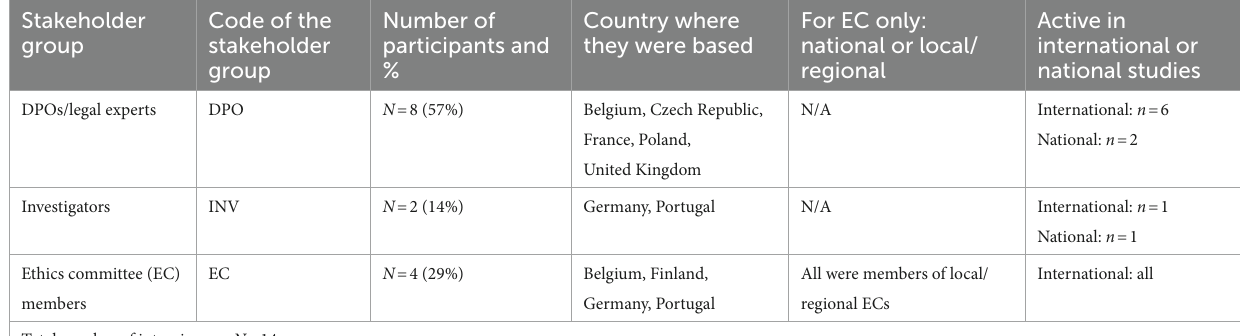
TABLE 1 Demographic characteristics of the interviewed